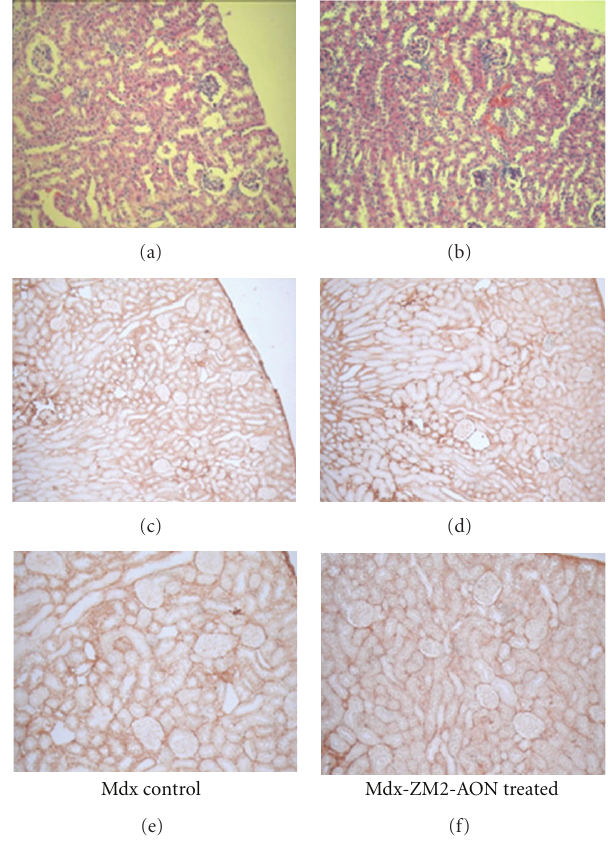
Figure 4: Tissue morphology analysis. Histological analysis on kidneys from control and ZM2-AON-treated mdx mice. (a) and (b) Hematoxylin and Eosin staining; (c–f) immunohistochemistry with anticollagen I antibody; (a–d) 10x; (e) and (f): 20x. No morphological alterations were observed in either group of